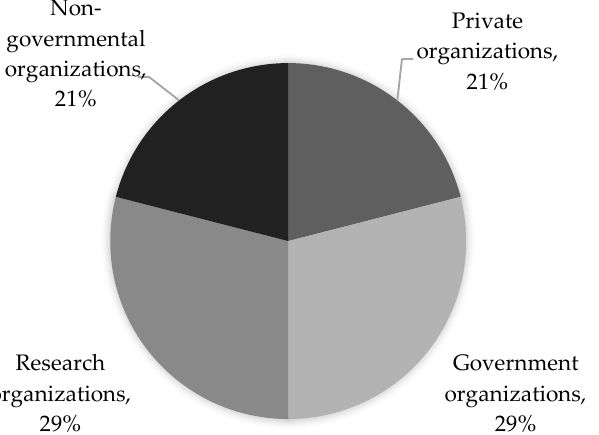
Figure 1. Selected stakeholders from four key groups for the biogas sector in Lithuania.